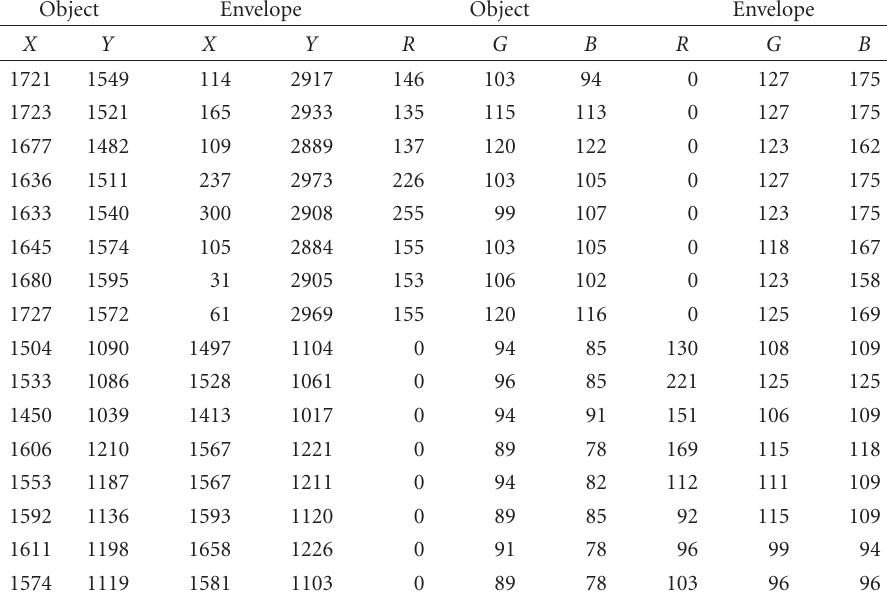
Table 4.3. Data recorded from Figure 4.3 for clustering.